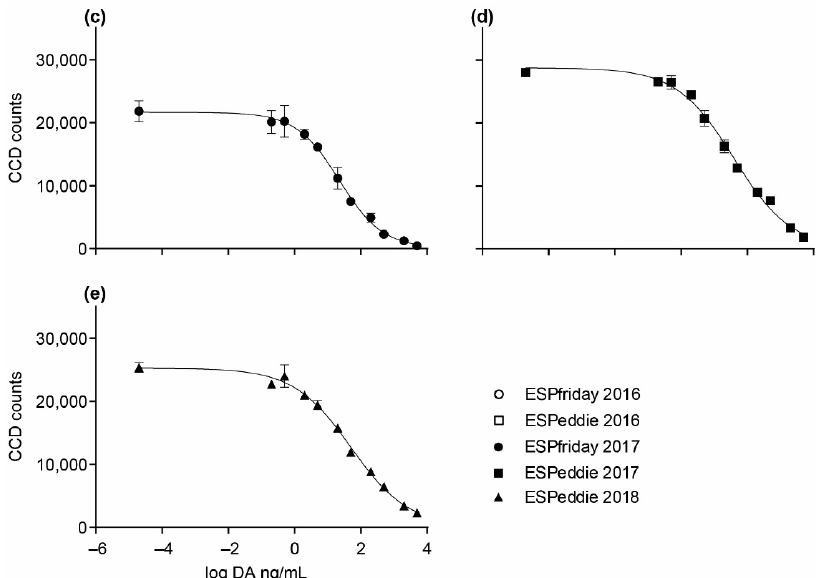
Figure 5. Domoic acid (DA) calibration curves for ESPfriday and ESPeddie in 2016, 2017, and 2018: ( a ) 2016 ESPfriday; ( b ) 2016 ESPeddie; ( c ) 2017 ESPfriday; ( d ) 2017 ESPeddie; and ( e ) I 2018 ESPeddie. Each point on the curve is the average spot intensity from 2 DA arrays (± SD). Parameters describing each curve are given in Table 2. Table 2. Parameters for the domoic acid (DA) calibration curves on ESPfriday and ESPeddie in 2016, 2017, and 2018. Parameters are determined based on a 4-parameter logistic fit (variable slope) of signals generated by DA certified reference material tested at 10 concentrations ranging from 0.2 to 5000 ng/mL, as well as a 0 ng/mL negative ( n = 2 for all values). The EC 50 represents the half-maximal response, whereas the EC 80 and EC 20 represent the lower and upper limits or bound- aries, respectively, of the linear dynamic range within which responses can be quantified accu- rately (i.e., LLOQ and ULOQ). The lower limit of detection (LLOD) refers to the lowest toxin con- centration (ng/mL) that can be detected but not quantified reliably (see text for additional details). ESP